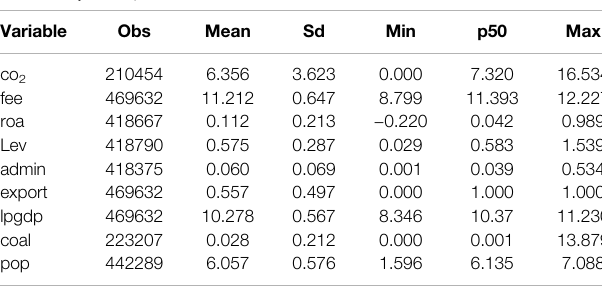
TABLE 2 | Descriptive statistics.